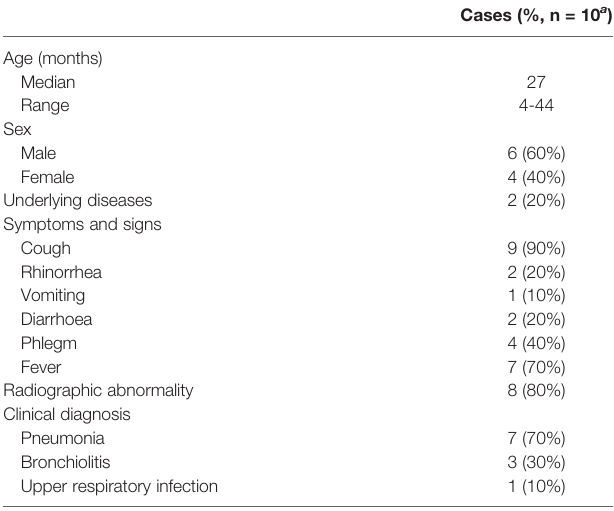
TABLE 4 | The demographic and clinical characteristics of patients positive for